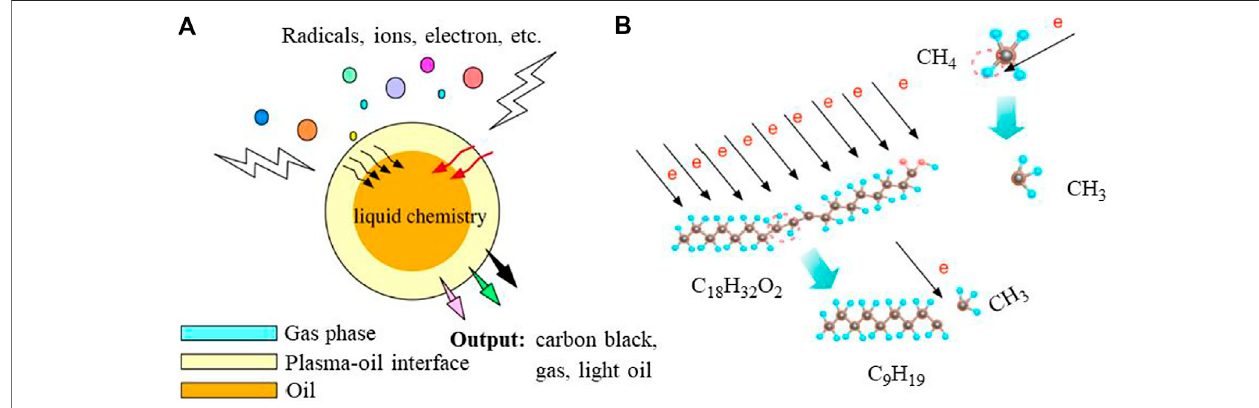
FIGURE 11 | (A) Decomposition of waste lard oil in PECVD and the effect of electron collisions, (B) breakdown of fatty acid chains induced by electron collisions (Wu et al., 2017).